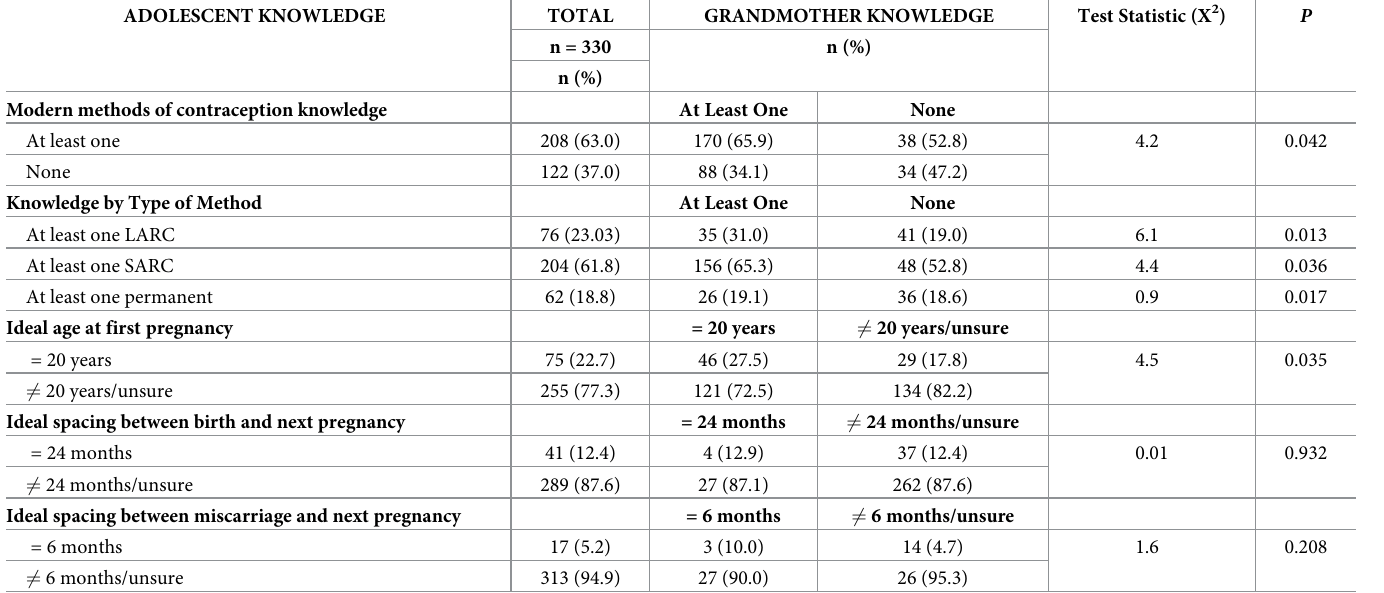
Table 3. Adolescent FP knowledge stratified by grandmother